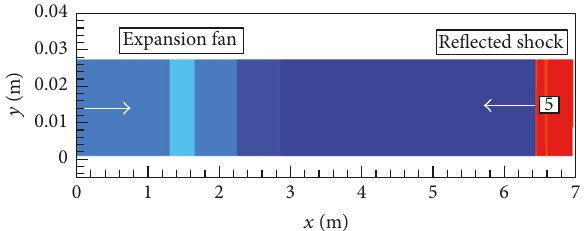
Figure 4: Pressure distribution after reflection from end wall.